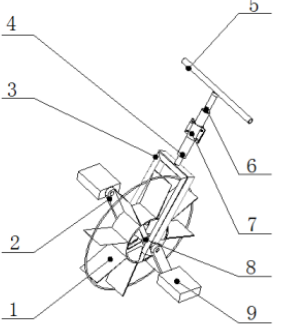
Figure 5. Structure of the driving component: (1) blade, (2) pedal crank, (3) front bracket, (4) front fork sleeve, (5) steering rod, (6) front fork tube, (7) upper clip, (8) central axis, (9) pedal.